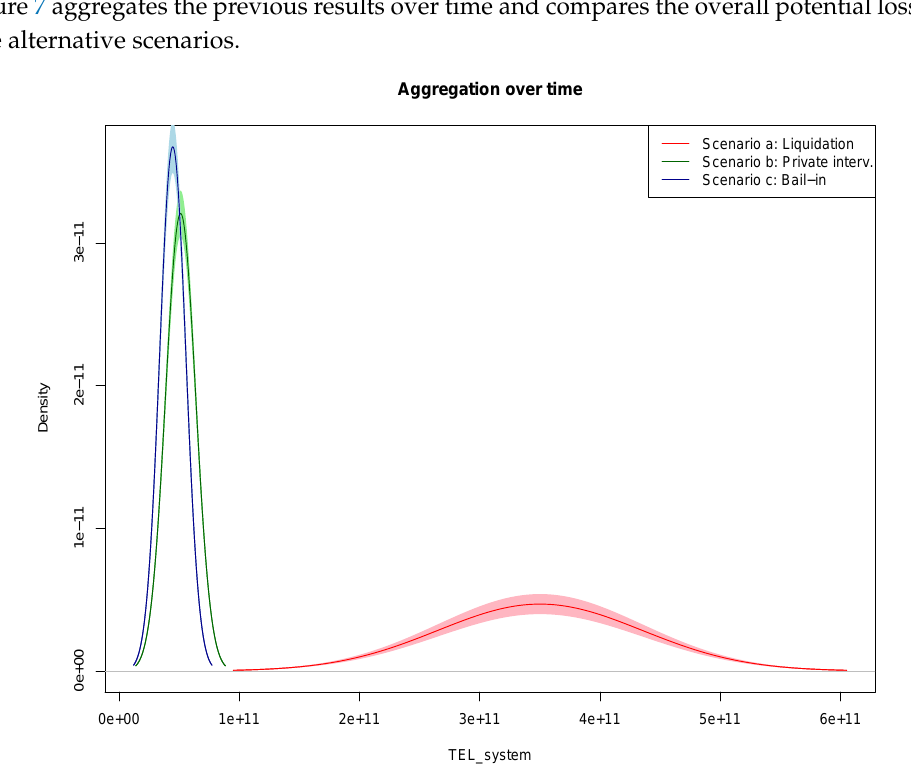
Figure 7. Total expected losses of the system when MPS is in trouble, aggregated over time. Notes: Monte Carlo simulated distributions of the expected losses of the entire banking system in case Monte dei Paschi di Siena is close to its default point, aggregated over time. Red lines represent the liquidation scenario; blue lines represent the private intervention action; while green lines stand for the bail-in scenario. Overall, the liquidation action seems to increase the expected losses of the entire banking system strongly; the private intervention and the bail-in tool, on the contrary, reduce financial instability and the sources of risk for the banking